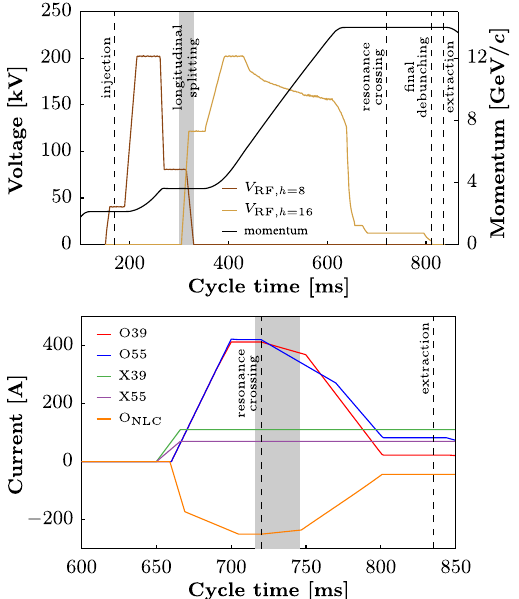
FIG. 2. Top: rf voltage program and magnetic cycle of the PS. Injection occurs at 2 . 14 Gev =c and extraction at 14 GeV =c . Bottom: Operational functions of the octupoles and sextupoles applied to perform the transverse splitting. O represents the NLC family of octupoles dedicated to the correction of nonlinear coupling. The grey area corresponds to the time during which the transverse dipolar excitation is